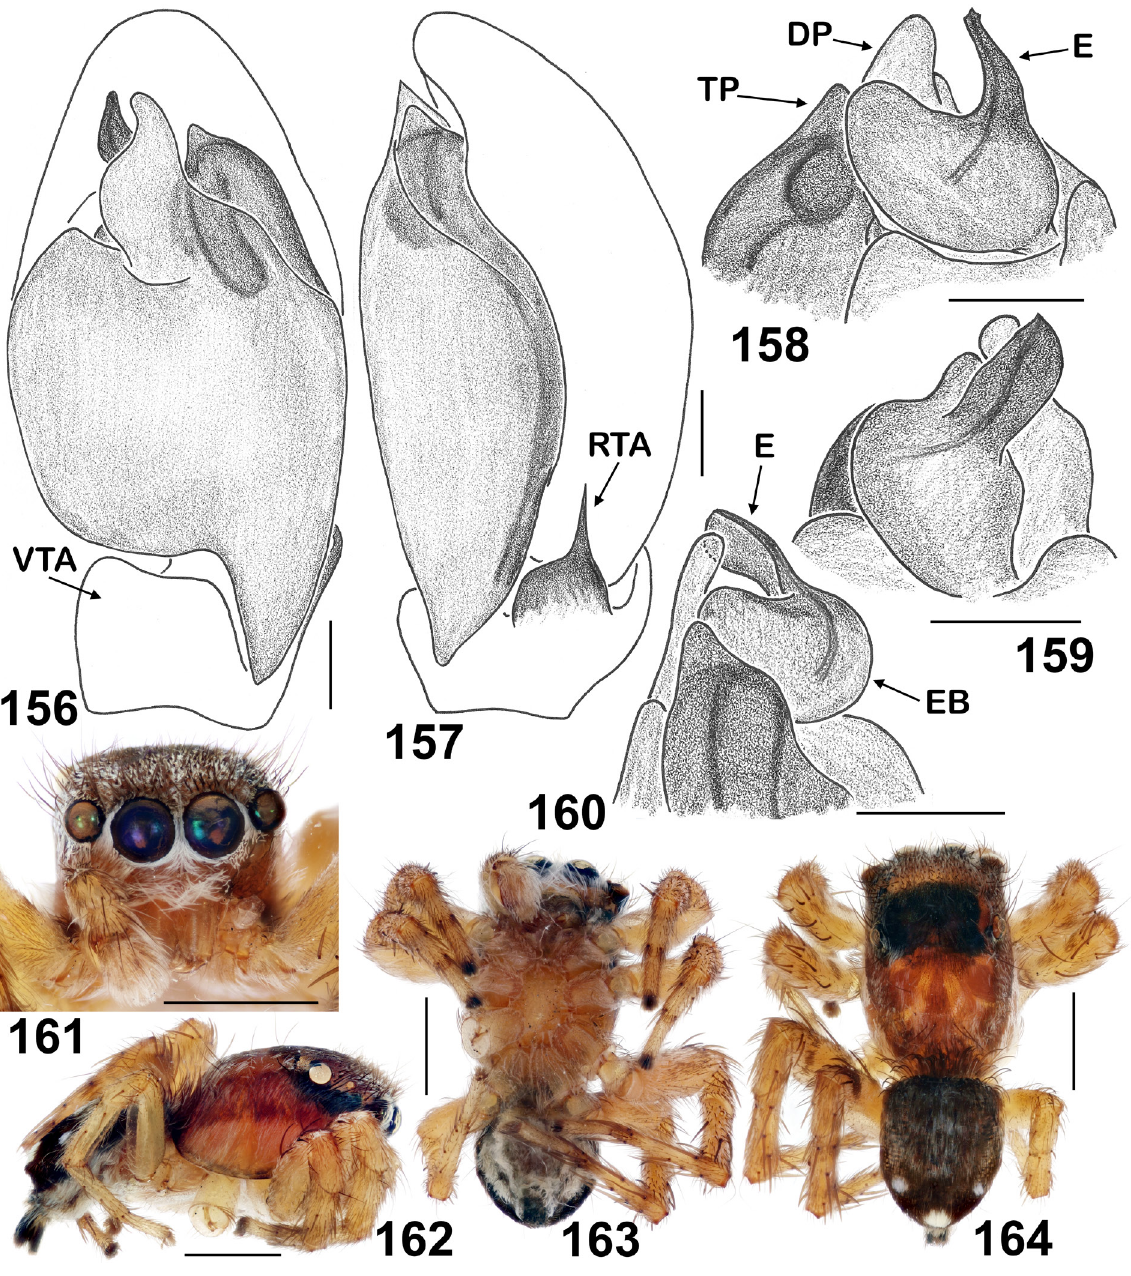
Figs 156–164. Stenaelurillus glaber Wesołowska & Russell-Smith, 2011, holotype, ♂ (156–160) and paratype, ♂ from Nigeria (Mokwa) (161–164). 156 . Male palp, ventral view. 157 . Male palp, retrolateral view. 158 . Embolic division, dorsal view. 159 . Embolic division, median view. 160 . Embolic division, retrolateral view. 161–164 . General appearance. Abbreviations: see Material and methods. Scale bars: 156–160 = 0.1 mm; 161–164 = 1